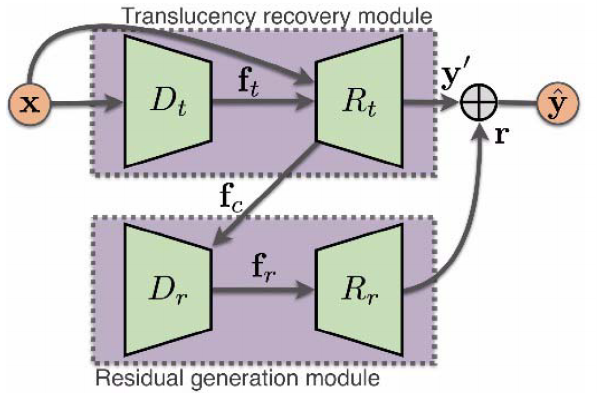
Figure 8. Schematic of the DesnowNet method by Liu et al. [29].